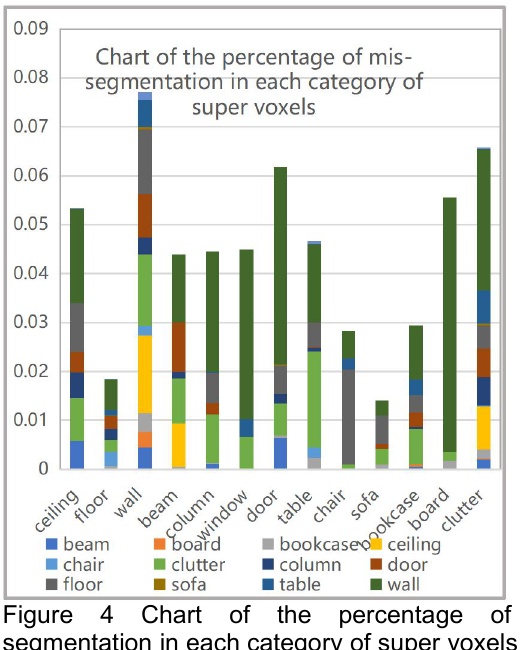
Figure 4 Chart of the percentage of mis- segmentation in each category of super voxels LSTM neural network training: In order to obtain an optimal training result, the convergence of the model under different epoch values was investigated, and iterative tests showed that the epoch parameter of the LSTM network proposed in this paper was set at around 80, which can effectively avoid the problem of model overfitting.